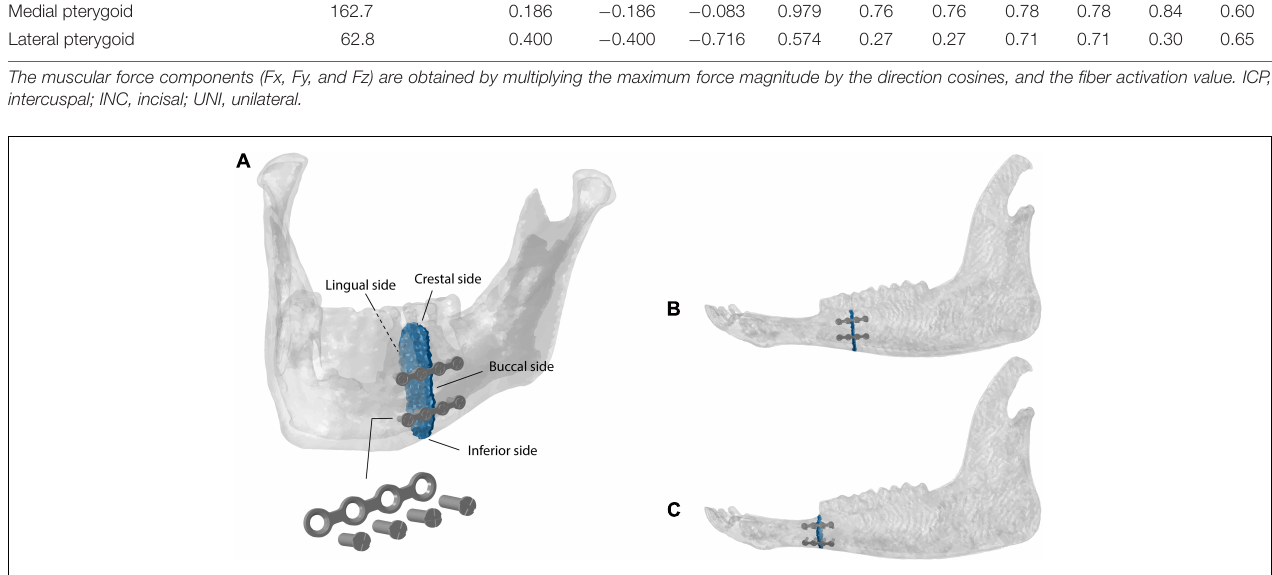
TABLE 3 | Muscle groups’ maximum force, direction cosines, and activation patterns, based on the specific clenching tasks in the sheep mandible. Sheep mandible muscle Maximum muscle force (N) Right Left Right Left Right Left Right